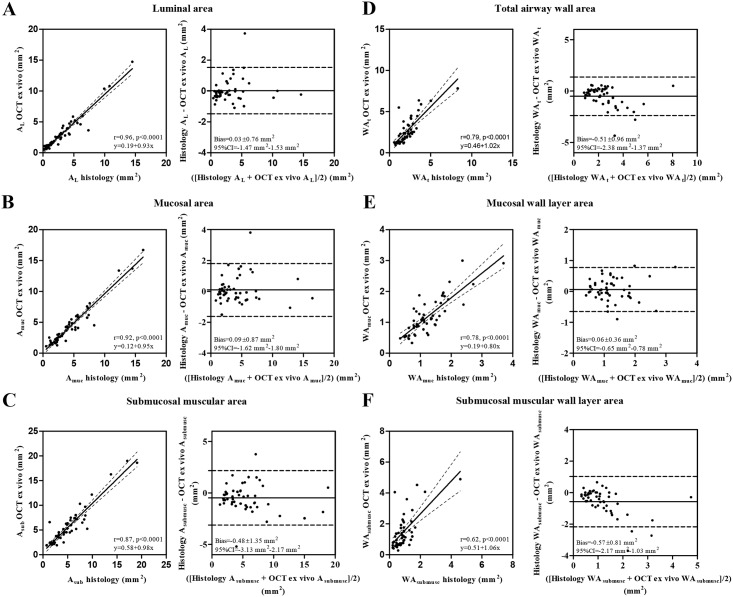
Linear regression analysis and Bland-Altman plots for histology and OCT ex-vivo airway wall area measurements (n = 51).(A) AL lumen area in mm2. (B) Amuc mucosal area in mm2. (C) Asubmusc submucosal muscular area in mm2. (D) WAt total airway wall area in mm2. (E) WAmuc mucosal wall area in mm2. (F) WAsubmusc submucosal muscular wall area in mm2.